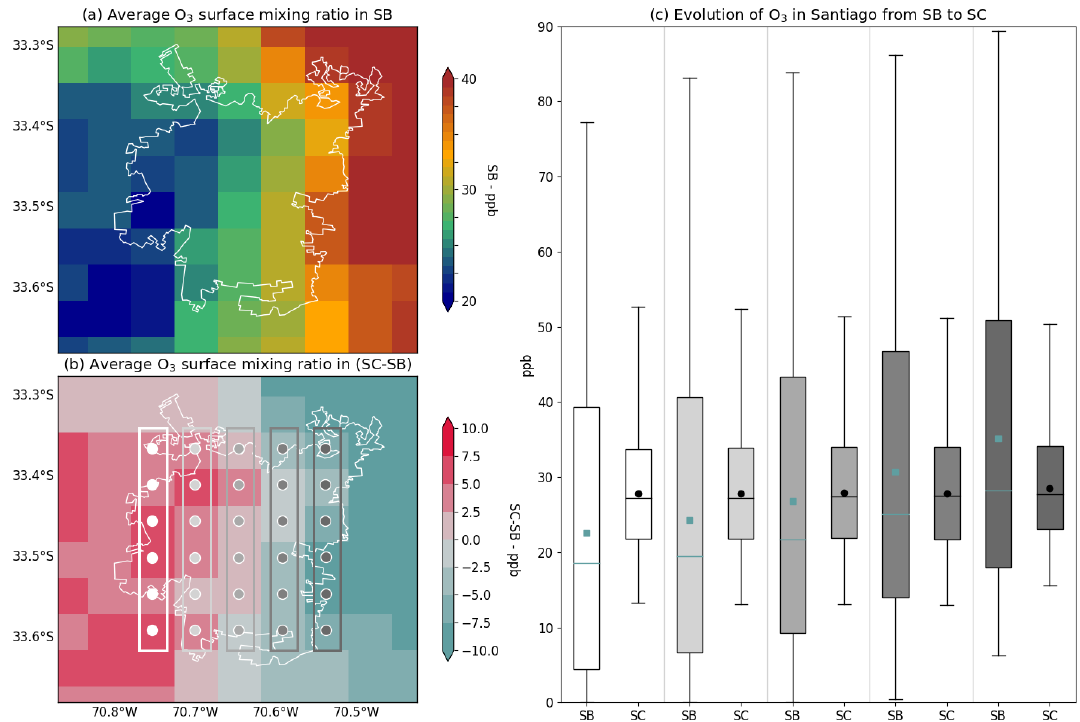
Figure 8. (a) Average O 3 mixing ratio at ground level in scenario SB in Santiago. Panel (b) is the same as panel (a) for scenario SC–SB. (c) Distribution of hourly O 3 surface mixing ratio in scenarios SB and SC. Boxes show the average, median, minimum, maximum, and first and third quartiles. Shades of gray correspond to the zones defined in (b) on which an average is